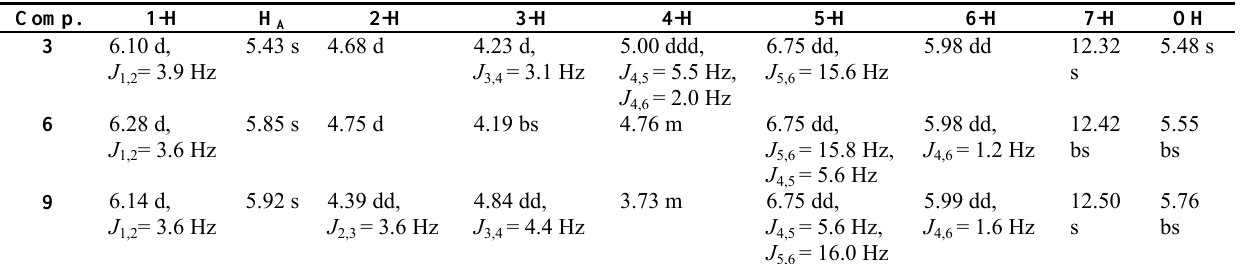
Table 1. The 1 H-NMR (400 MHz) chemical shifts ( δ ppm) and J Knoevenagel-Doebner condensation products of chloraloses. Comp.